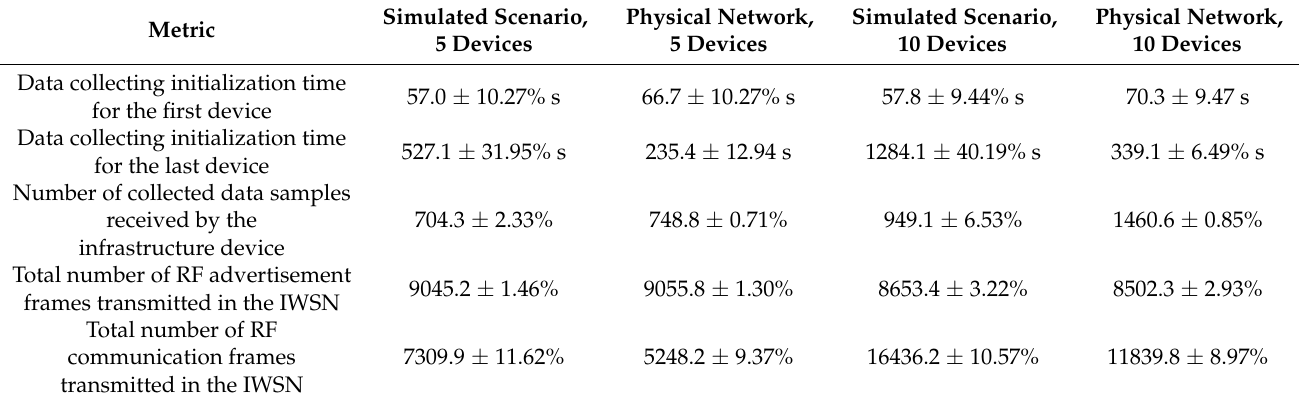
Table 6. Relative standard deviations of scalability metrics related to IWSN